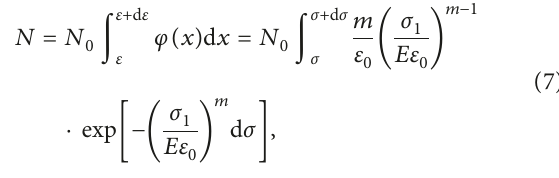
Figure 1: Mechanism of charge generation with crack sliding and friction interface dislocation potential